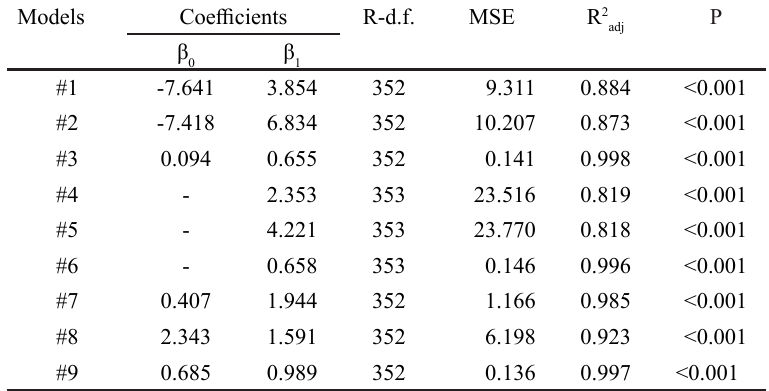
Table 3. Statistical models, regression co efficients (β of residuals (R-d.f.), mean squared error (MSE) , coefficients of determination adjusted for the degrees of freedom (R 2 dimensions of leaves.